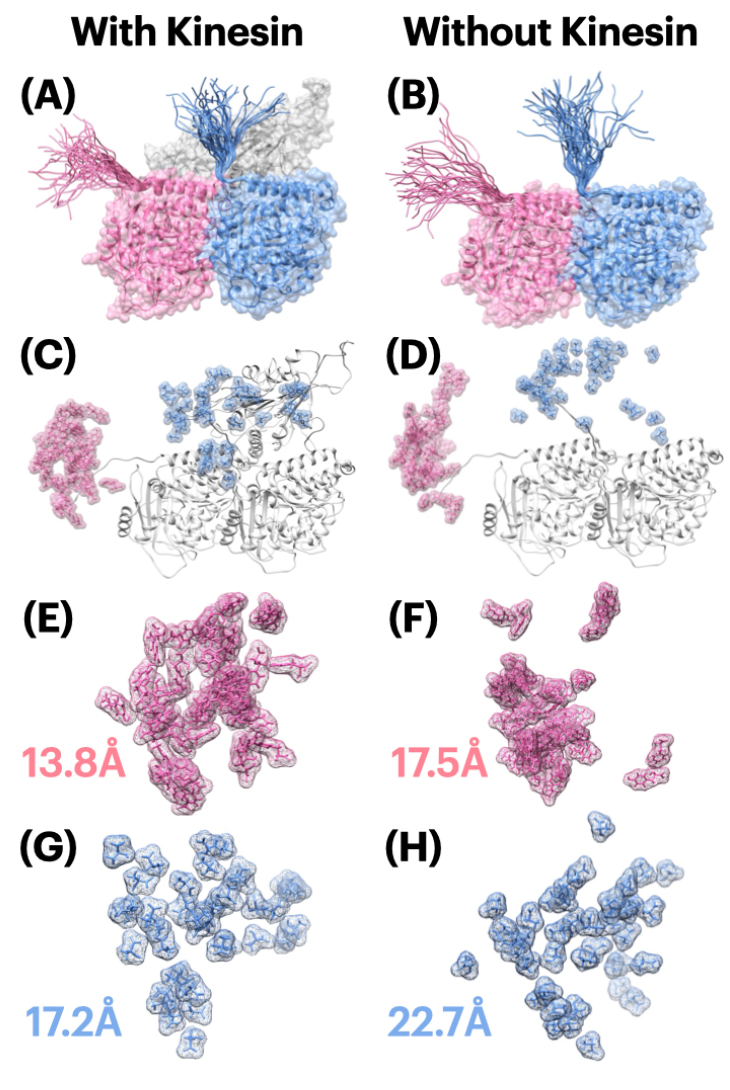
Figure 2. E-hooks flexibility analysis. ( A ) E-hooks moving range visualization with the presence of kinesin; ( B ) E-hooks moving range visualization without the presence of kinesin; ( C ) Moving range of the last amino acid residue of E-hooks (Y in alpha tubulin, A in beta tubulin), with the presence of kinesin; ( D ) Moving range of the last amino acid residue of E-hooks (Y in alpha tubulin, A in beta tubulin), without the presence of kinesin; ( E ) Moving range of the last amino acid residue of alpha tubulin E-hooks (Tyr, Y), with the presence of kinesin, and the flexibility index is 13.8 Å; ( F ) Moving range of the last amino acid residue of alpha tubulin E-hooks (Tyr, Y), without the presence of kinesin, and the flexibility index is 17.5 Å; ( G ) Moving range of the last amino acid residue of beta tubulin E-hooks (Ala, A), with the presence of kinesin, and the flexibility index is 17.2 Å; ( H ) Moving range of the last amino acid residue of beta tubulin E-hooks (Ala, A), without the presence of kinesin, and the flexibility index is 22.7 Å.